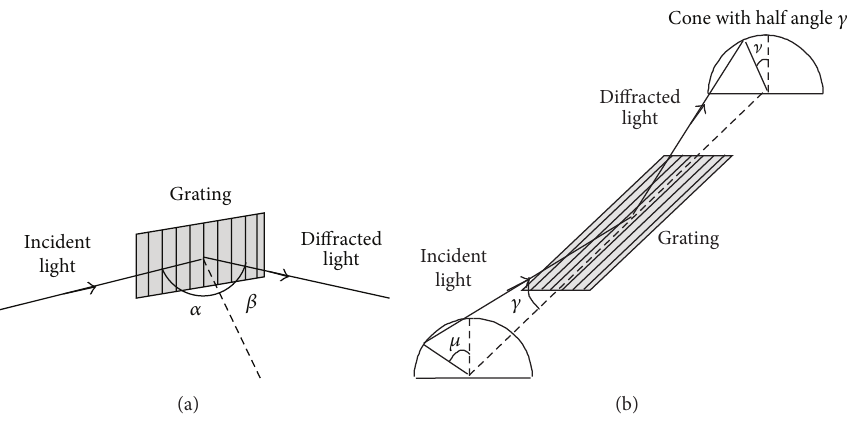
Figure 1: Reflection grating geometries: (a) classical-diffraction and (b) off-plane